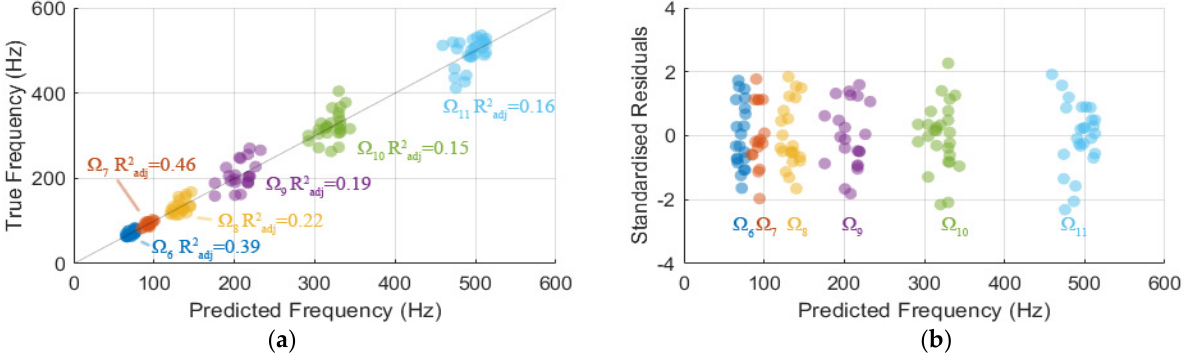
Figure 4. ( a ) Graph of predicted and true modal frequencies and ( b ) graph of standardised residuals against predicted frequency.